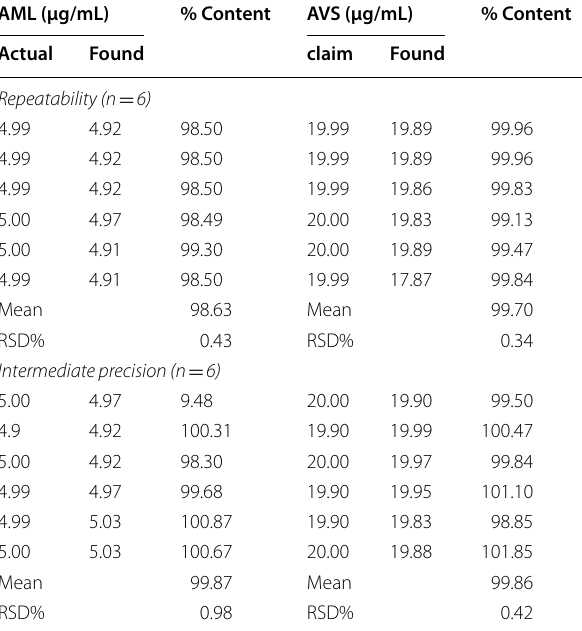
Table 8 The precision of the absorbance factor method AML (µg/mL) % Content